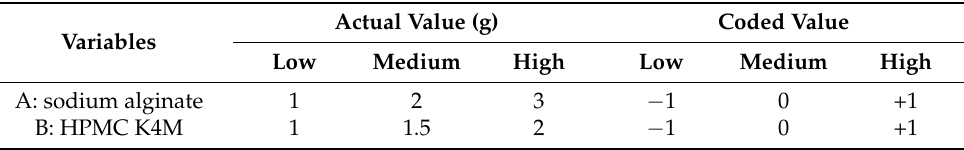
Table 2. Composition of independent variables and their levels for the preparation of the oral raft-forming in situ gelling system of NTB, an anticancer